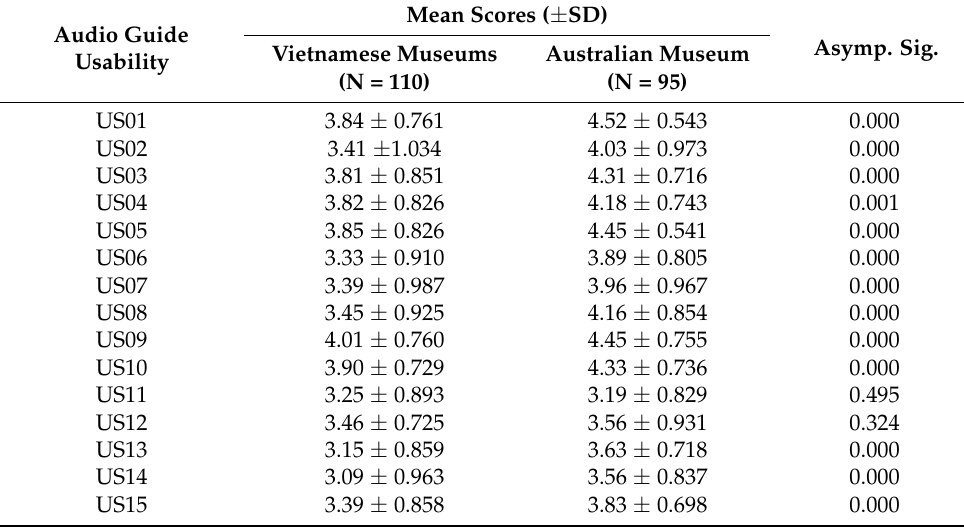
Table 6. Usability evaluation of audio guides: Mean, SD, and p